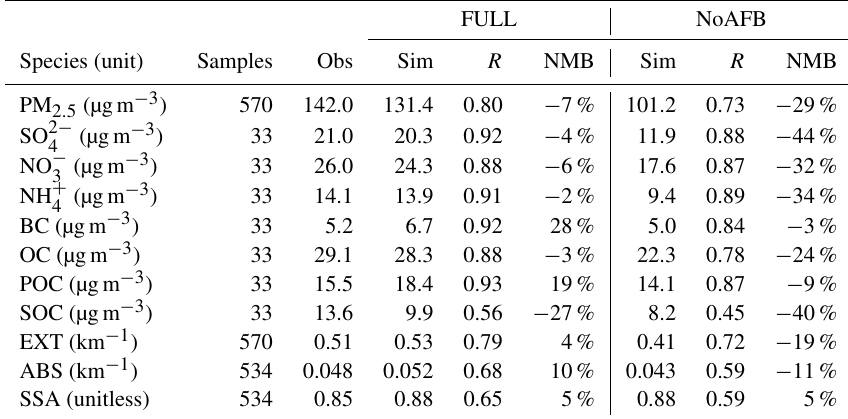
Table 2. Performance statistics for PM 2 . 5 concentration, and its chemical components, and aerosol optical parameters at RH = 10% (EXT, ABS, and SSA) at the IAP site in Beijing. Mean observation (Obs), mean simulation (Sim), correlation coefficient ( R ), and normalized mean bias (NMB in %) are listed.